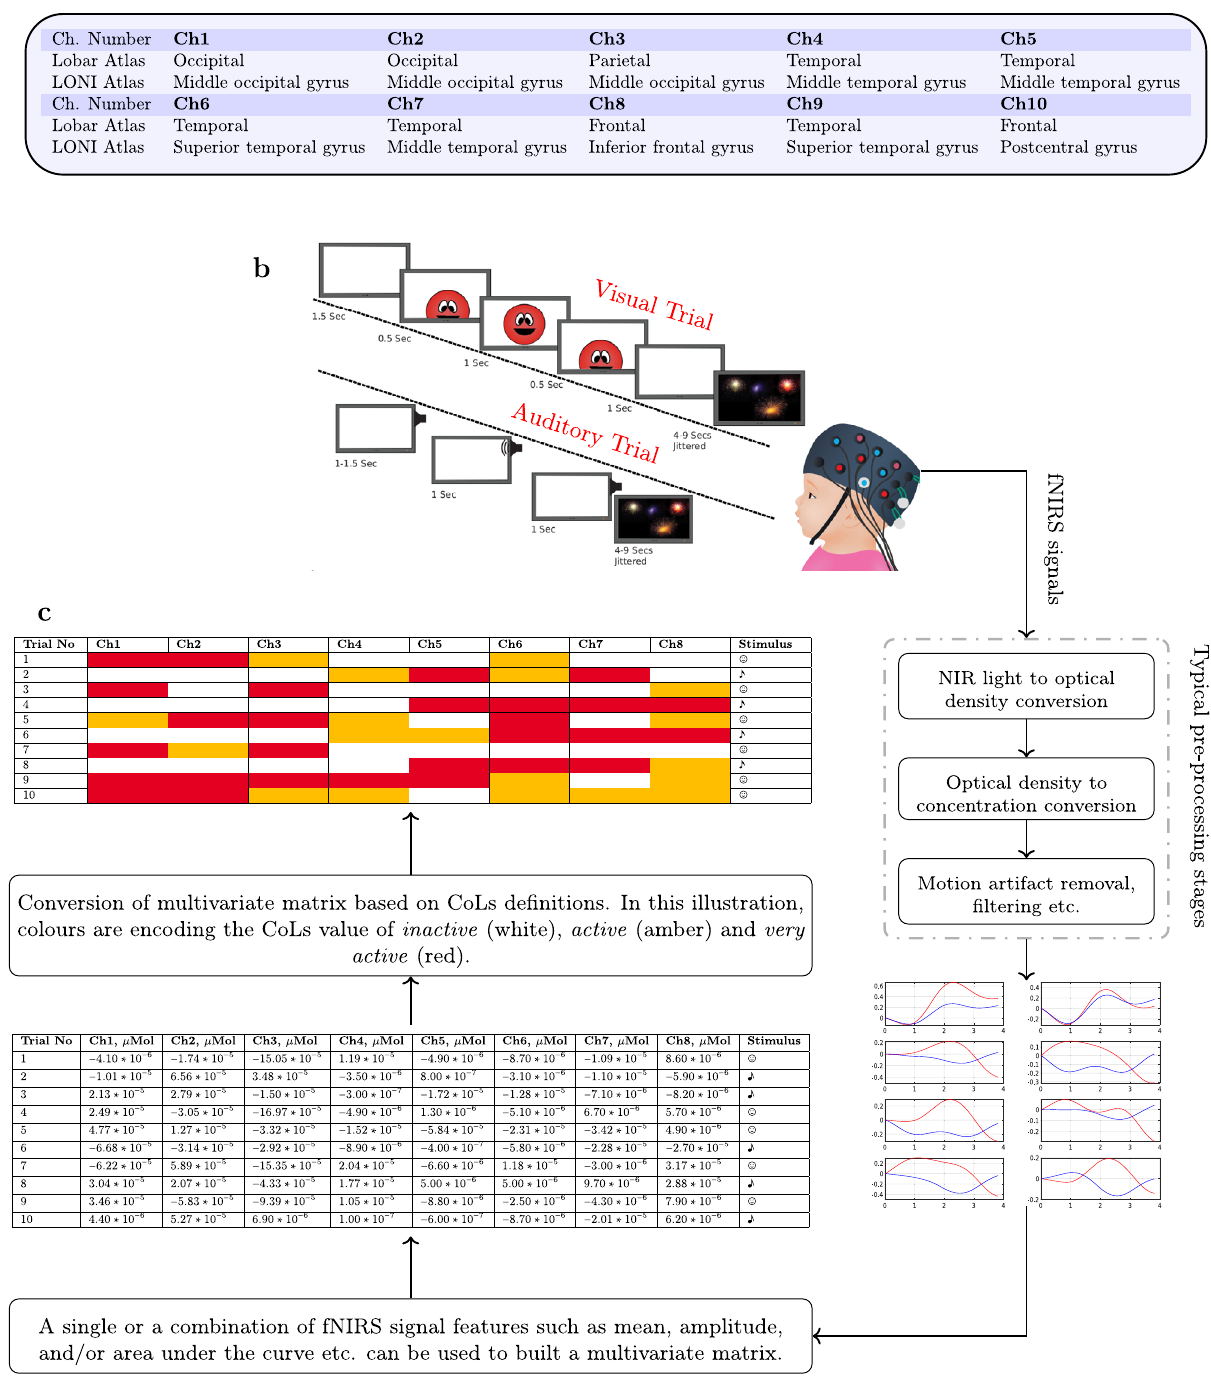
Fig. 1 Multivariate pattern matrix construction using fNIRS signals. a The average anatomical location of the 10 channels (Chs) after MRI co-registration using Lobar and LONI atlas as delineated in Emberson et al. 19 . b A schematic of the Auditory vs. Visual (AV) Experiment in Emberson et al. 19 . The auditory stimulus is a toy sound played for one second, and the visual stimulus is a red smiley face that moves in and out of a box. Please note the location of sources and detectors on the fNIRS cap is hypothetical. c A fl owchart depicting the steps for the construction of a multivariate pattern matrix with hypothetical numerical neuroimaging data from (arbitrarily chosen) eight fNIRS channels (Chs) associated with two stimulus conditions for ten trials. The numerical multivariate pattern matrix is converted into a conceptual multivariate pattern matrix using conceptual labels (CoLs) of inactive , active , and very active . Please note the numerical values are hypothetical, and since their conversion to the CoLs would depend on which statistical feature of the fNIRS signals has been used, as well as the corresponding de fi nition of the membership function of the associated CoLs (see Fig. 6), no direct inference between the numerical value and the CoL can be made in this